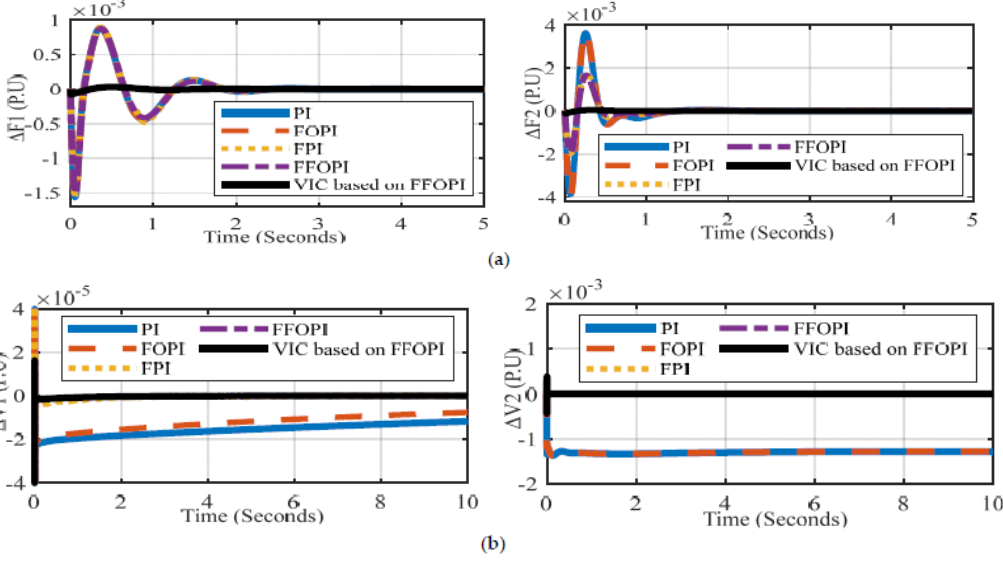
Figure 18. Interconnected microgrid’s frequency and voltage measurements versus time for each